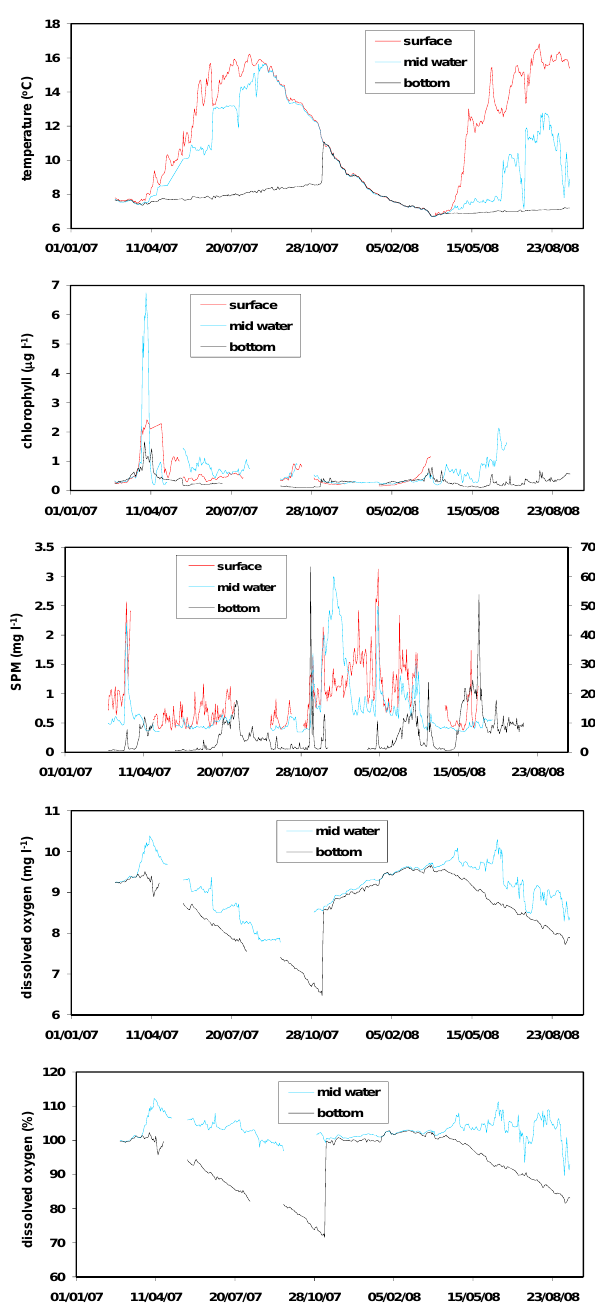
Fig. 4. Mooring data from North Dogger for (a) temperature, (b) chlorophyll, (c) SPM (surface and mid-water on primary y axis, bot- tom on secondary y axis), (d) oxygen concentration and (e) oxygen percent